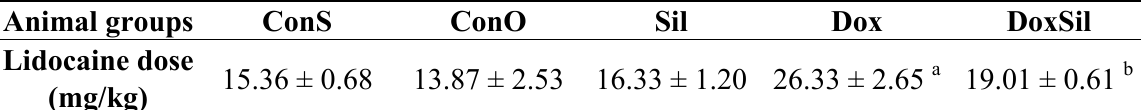
Table 2. Dose of lidocaine, administered through continuous intravenous infusion, required for causing bradycardia in control saline (ConS) and control oil (ConO), and experimental groups treated with silymarin (Sil), doxorubicin (Dox) and the combination of doxorubicin and silymarin